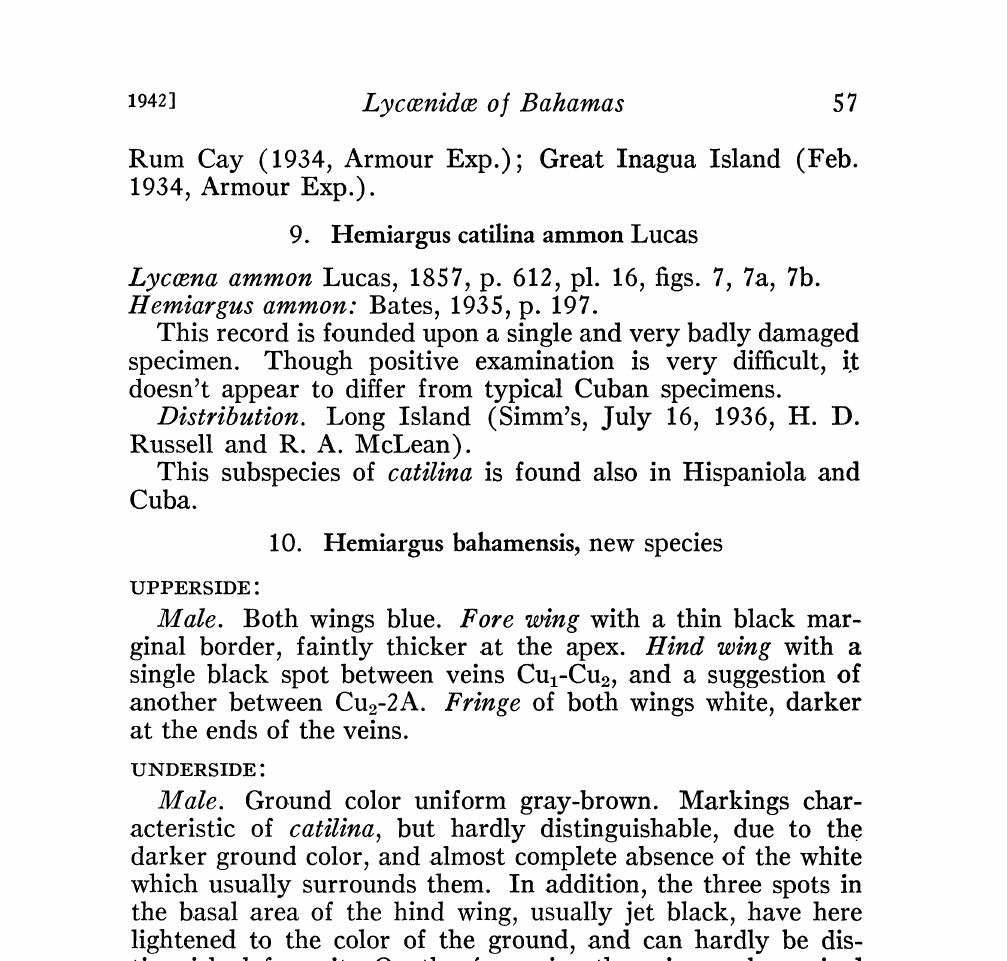
Male. Both wings blue. Fore wing with a thin black mar- ginal border, faintly thicker at the apex. Hind wing with a single black spot between veins Cu-Cu, .and a suggestion of another between Cu-2A. Fringe of both wings white, darker at the ends of the veins. Male. Ground color uniform gray-brown. Markings char- acteristic of catilina, but hardly distinguishable, due to the darker ground color, and .almost complete absence of the white which usually surrounds them. In addition, the three spots in the basal area of the hind wing, usually jet black, have here lightened to the color of the ground, and can hardly be dis- tinguished from it. On the fore wing there is a submarginal line of white, rather thin, .contrasting sharply with the dark gray-brown which surrounds it. On the hind wing there is a corresponding white line, slightly thicker, which runs from costa to inner margin, as does that of the fore wing. On the outer margin, near the anal .angle, are two black spots, irrorated heavily with metallic blue green scales on their outer margins. The one in Cu-Cu is capped by .a thin curved line of orange, while the smaller one adjacent to it is capped by a similar line of white. Length of fore wing 9